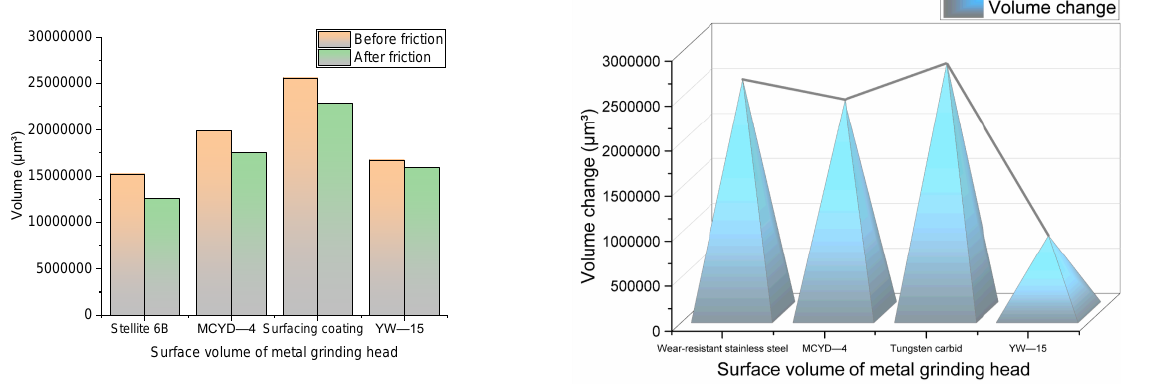
Figure 13. The change of metal volume before and after friction between different metals and NR/BR composites.